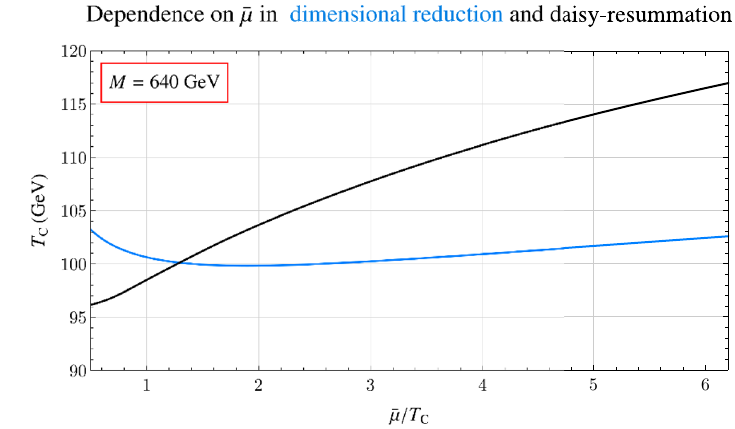
Figure 3 . The remormalisation scale dependence of the critical temperature, T (black) and 3d (blue) approaches at the benchmark point M = 640 GeV. As discussed in the text, in the 3d approach the other thermodynamic parameters show a similar ¯ µ dependence to T c